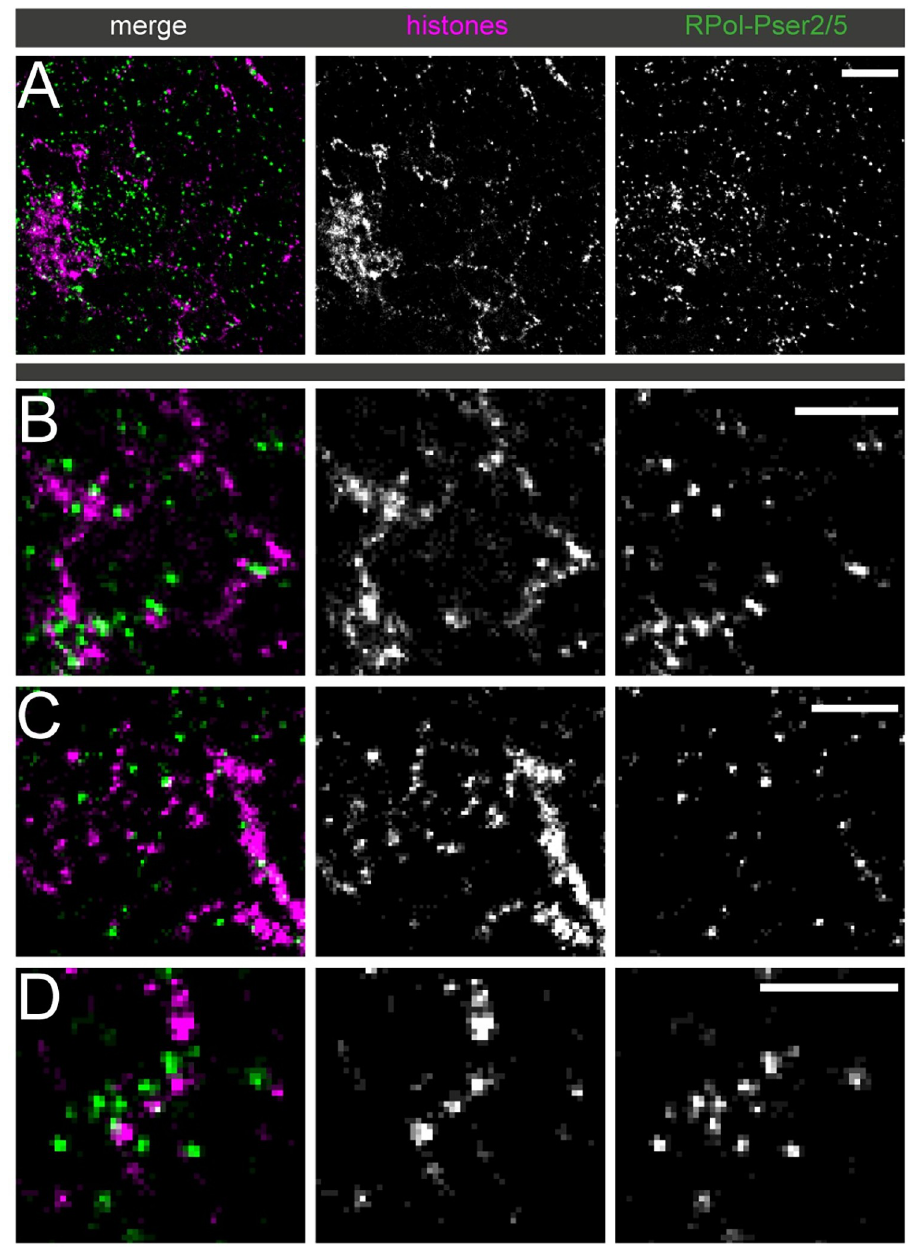
Fig 8. Association of Y loops to RPol-PSer2/PSer5. Dual-colour STORM images of immunolabelled histones (magenta) and polymerase foci (green) using an antibody recognizing both RPol-Pser2 and RPol-PSer5. (A) gives an overview, scale bar is 1 μ m and (B to D) show selected examples at higher power, scale bars are 500nm. The polymerase foci are generally not present between the nucleosome clusters.